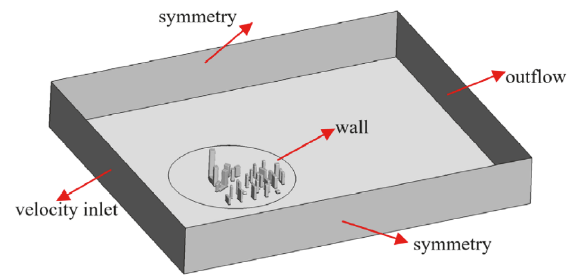
Figure 2: Group buildings model and the computational domain.